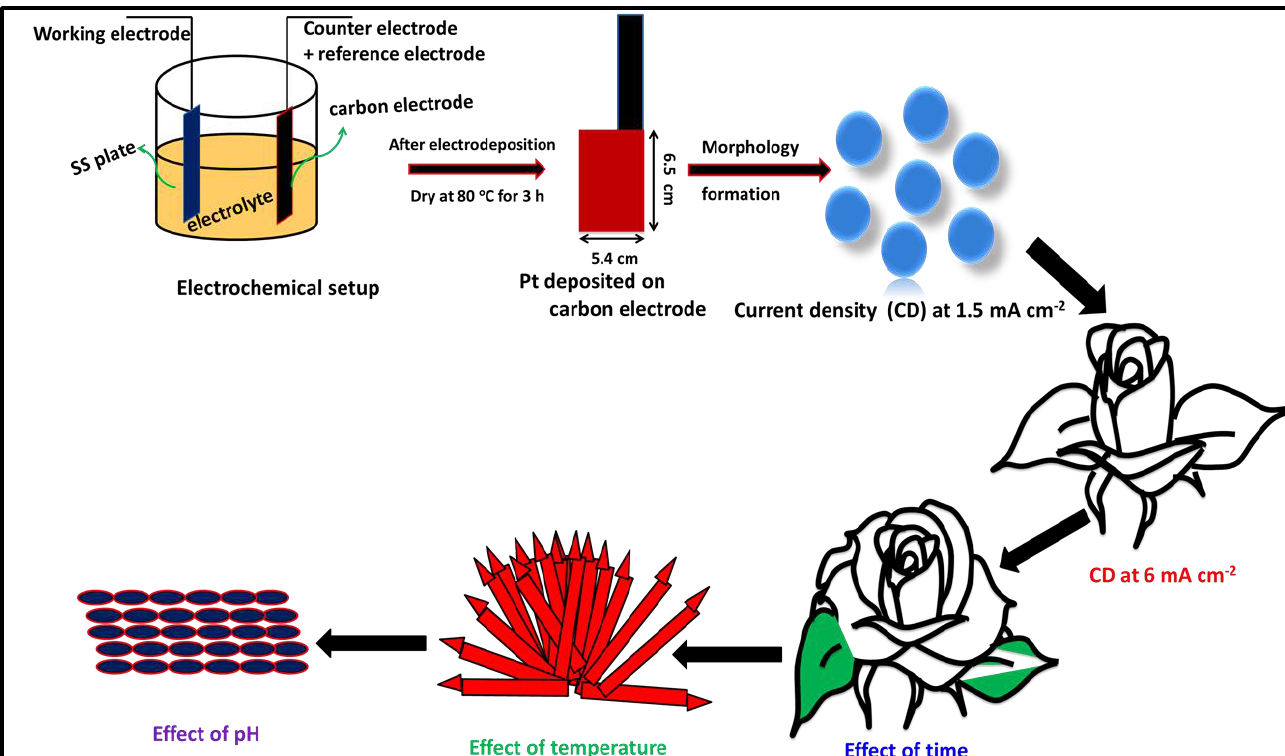
Scheme 1. Schematic diagram of electrochemical two electrode systems and formulated electrolyte with exposed conductive carbon substrate (5.4 cm × 6.5 cm) and proposed Pt morphology.